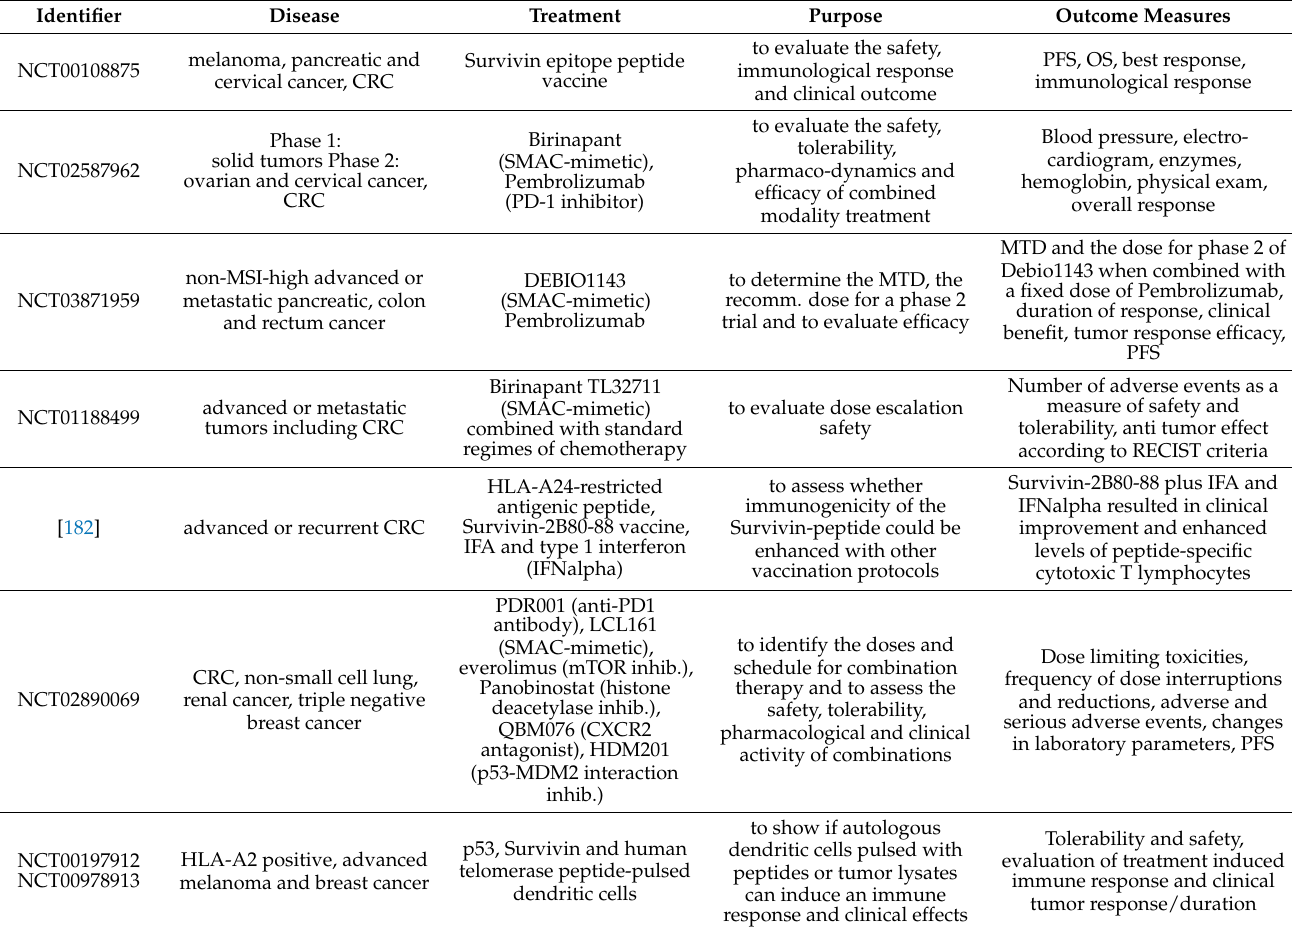
Table 2. Clinical studies targeting IAPs and